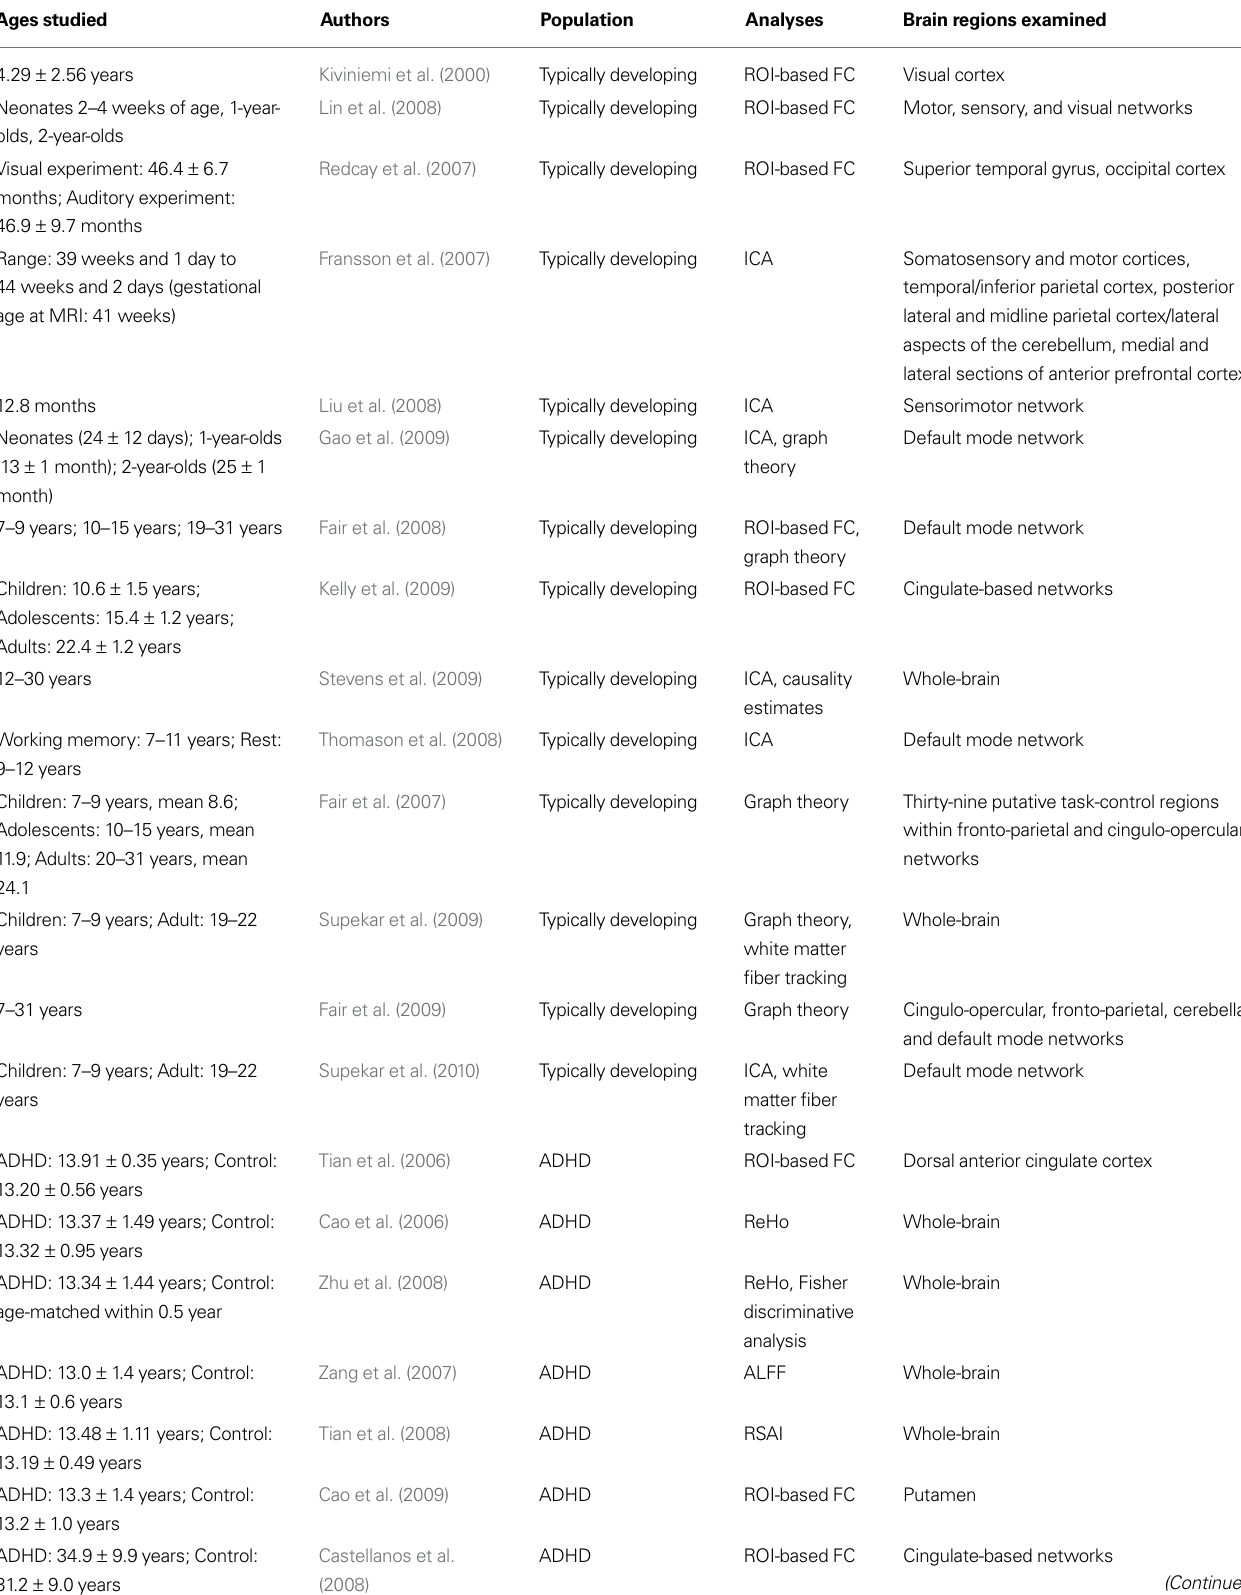
Table 1 | Summary of resting-state fMRI studies in infants, children and adolescents, including neurodevelopmental disorders. Ages studied Authors Population Analyses Brain regions examined 4.29 ± 2.56 years Kiviniemi et al. (2000) Typically developing ROI-based FC Visual cortex Lin et al. (2008) Typically developing ROI-based FC Motor, sensory, and visual